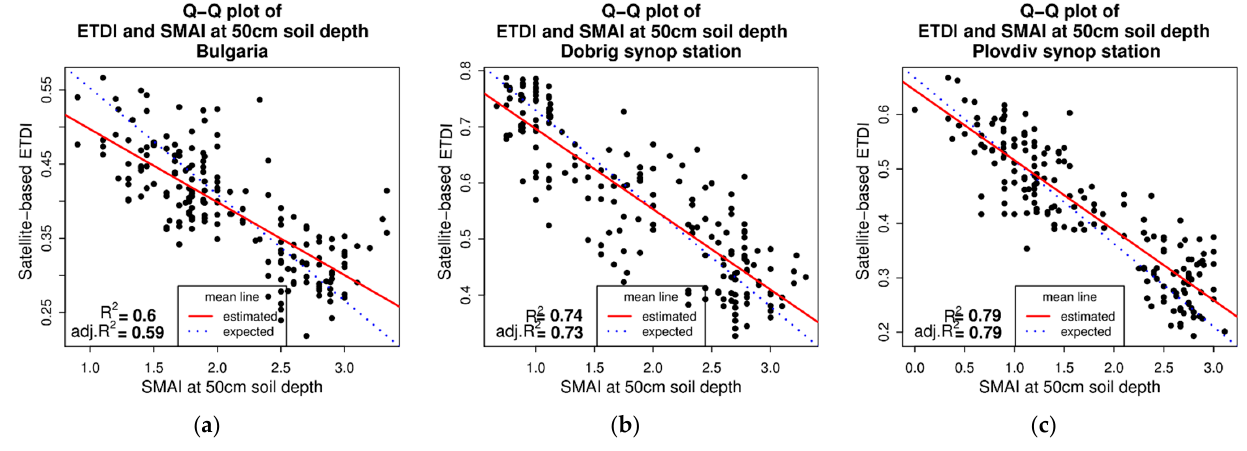
Figure 10. Q–Q plots comparing the distributions of the monthly mean ETDI and SMAI at 50 cm soil depth (red line): ( a ) mean values from 26 synoptic stations in Bulgaria; ( b ) a station in north Bulgaria; indicates the ideal diagonal of the linear